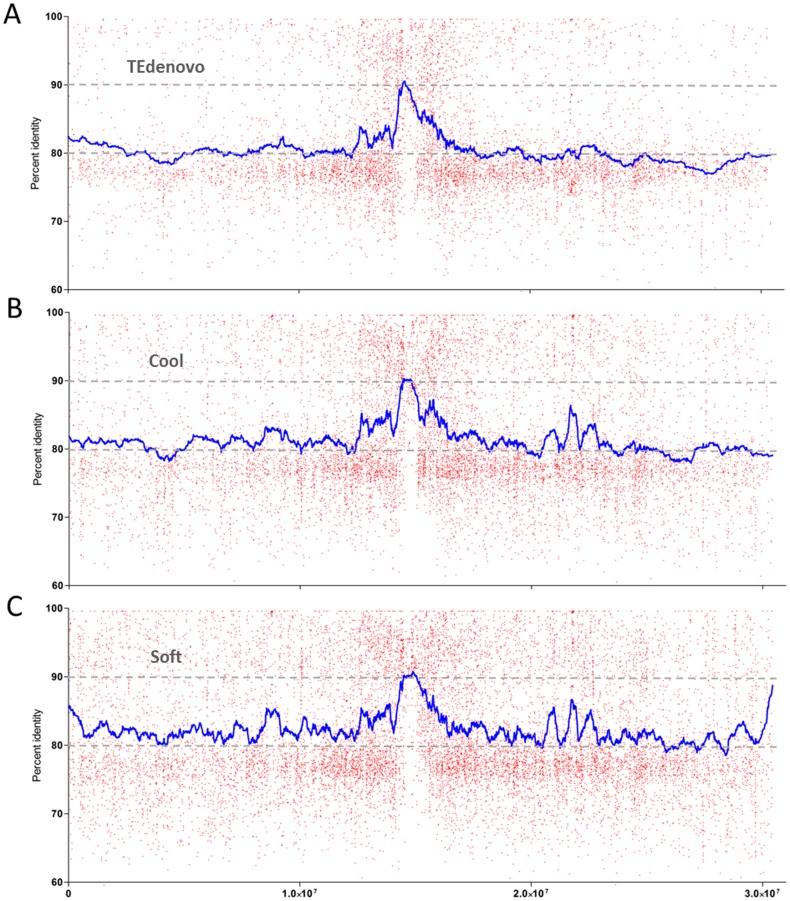
Landscape of identity values.Plot and smoothed curve (100 neighbors) of the identities between genomic copies and consensus sequences from TEdenovo (A), TEdenovo_cool (B), and TEdenovo_soft (C) along A. thaliana chromosome 1. Because identity values are not equally spaced, the smoothing is approximate and is not strictly “Savistsky-Golay” smoothing.